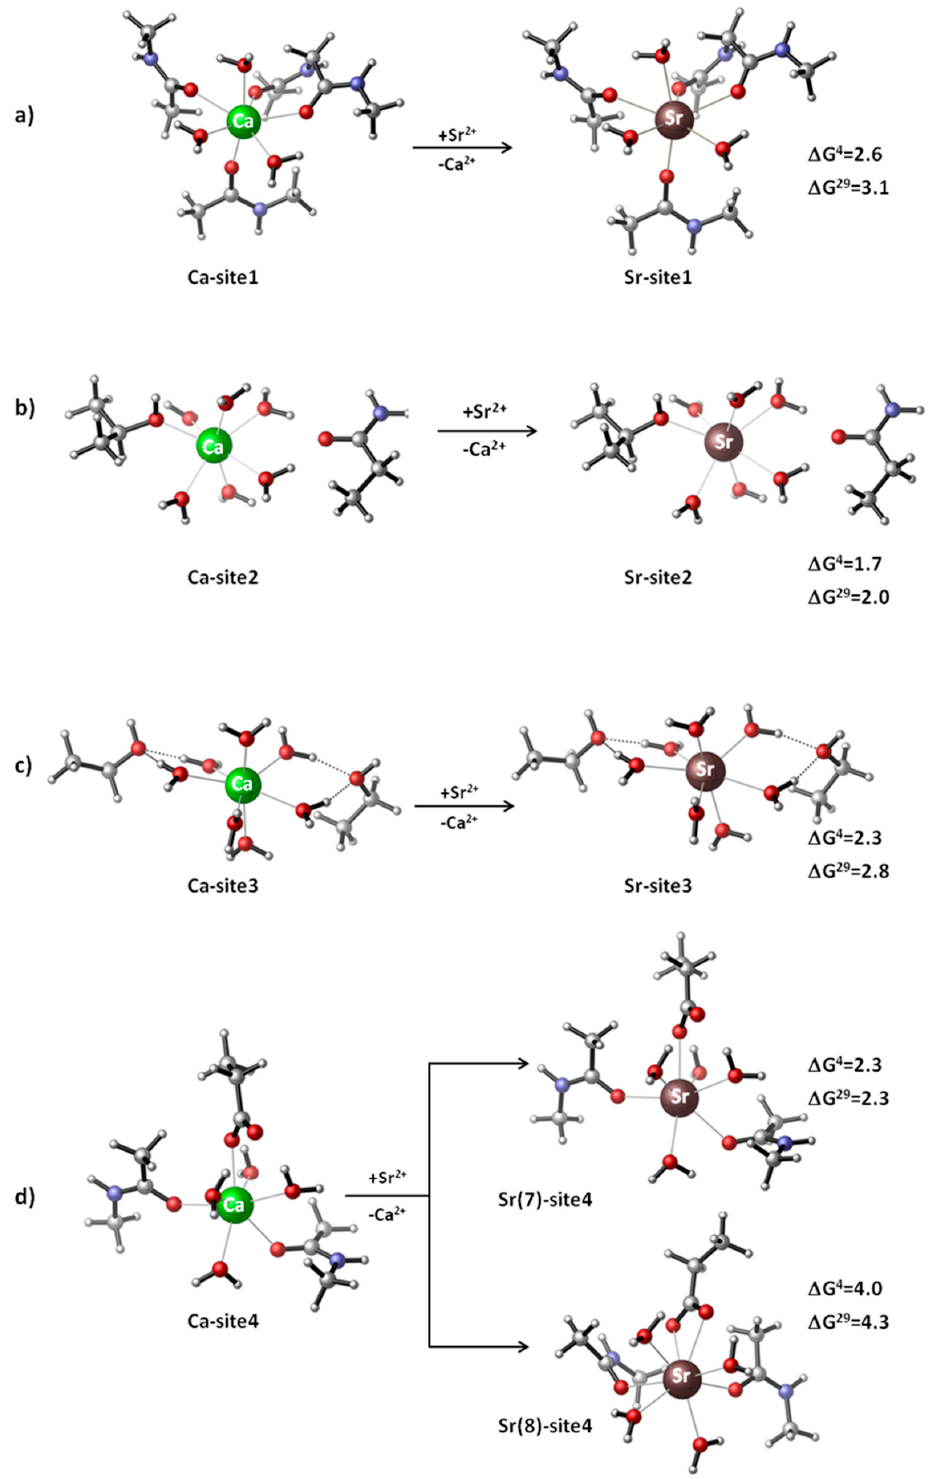
Figure 1. M06-2X/6-311++G**//SDD fully optimized Ca 2+ and Sr 2+ -loaded metal binding sites of CaSR: ( a ) Site 1, ( b ) Site 2, ( c ) Site 3 and ( d ) Site 4. Gibbs free energies (in kcal/mol) of the Ca 2+ → Sr 2+ substitution are also given: ∆ G 4 stands for the free energy evaluated for buried metal binding sites, whereas ∆ G 29 signifies the metal exchange free energy for solvent-accessible binding pockets. Positive Δ G 4/29 suggests a Ca 2+ ‐ selective metal center. Reprinted from Ref. [28]. Copyright 2021 MDPI.